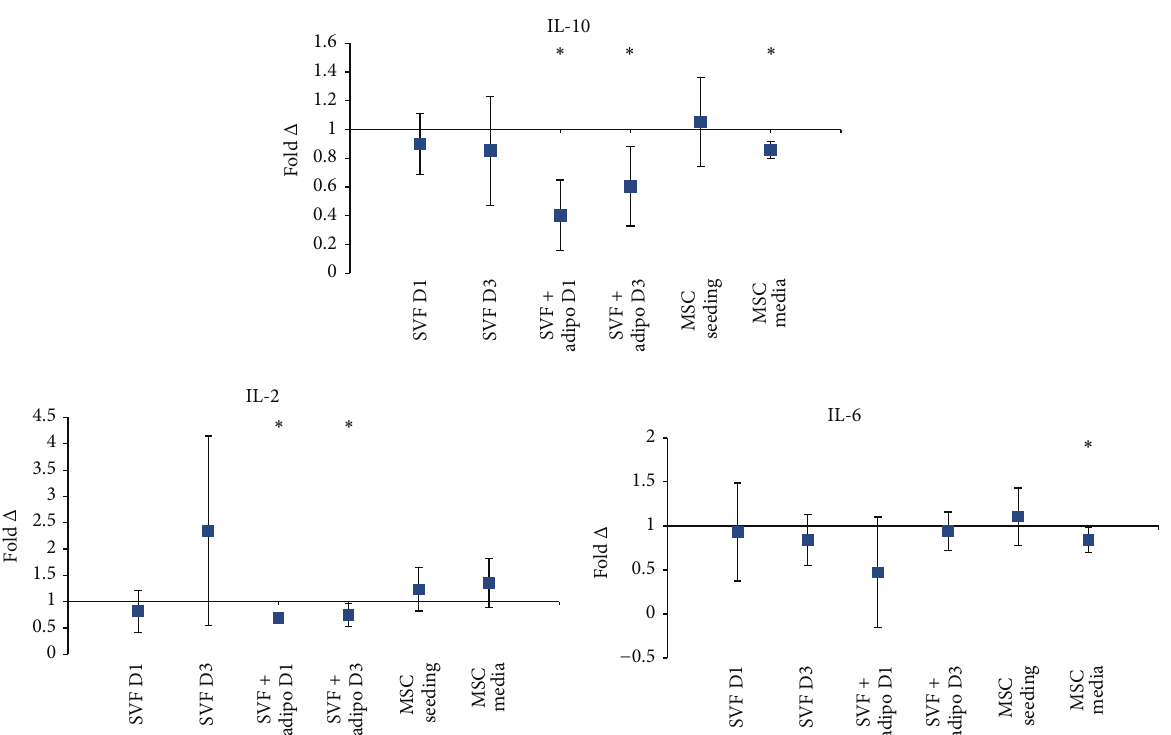
Figure 5: Fold change in concentration of anti-inflammatory and dual role cytokines detected across experiments. Average fold change in concentration ( 𝑛 = 3 ) ± upper and lower confidence intervals at 95% ( 𝑦 -axis). Conditions ( 𝑥 -axis): stromal vascular fraction on day 1 (SVF D1), stromal vascular fraction on day 3 (SVF D3), stromal vascular fraction plus mature adipocytes on day 1 (SVF + adipo D1), stromal vascular fraction plus mature adipocytes on day 3 (SVF + adipo D3), seeding experiment with purified MSCs (MSC seeding), and media change experiment with purified MSCs (MSC media). Conditions were all cultured in either standard culture media or HA media. Cytokines with a fold change less than one indicate a decrease in concentration with HA media treatment, and a fold change greater than one indicates an increase in the cytokine with HA treatment. Interleukin-10 (IL-10), interleukin-2 (IL-2), and interleukin-6 (IL-6).